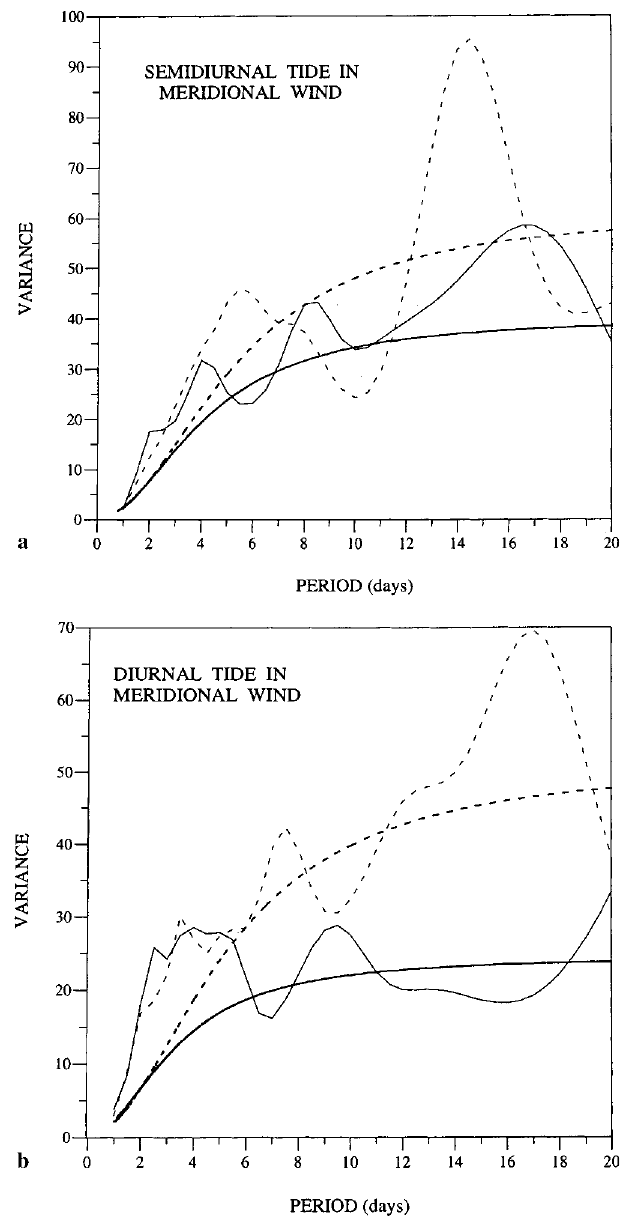
Fig. 12. a The same as Fig. 11a, but for the amplitudes of the semidiurnal meridional tide. b The same as a , but for the amplitudes of the diurnal